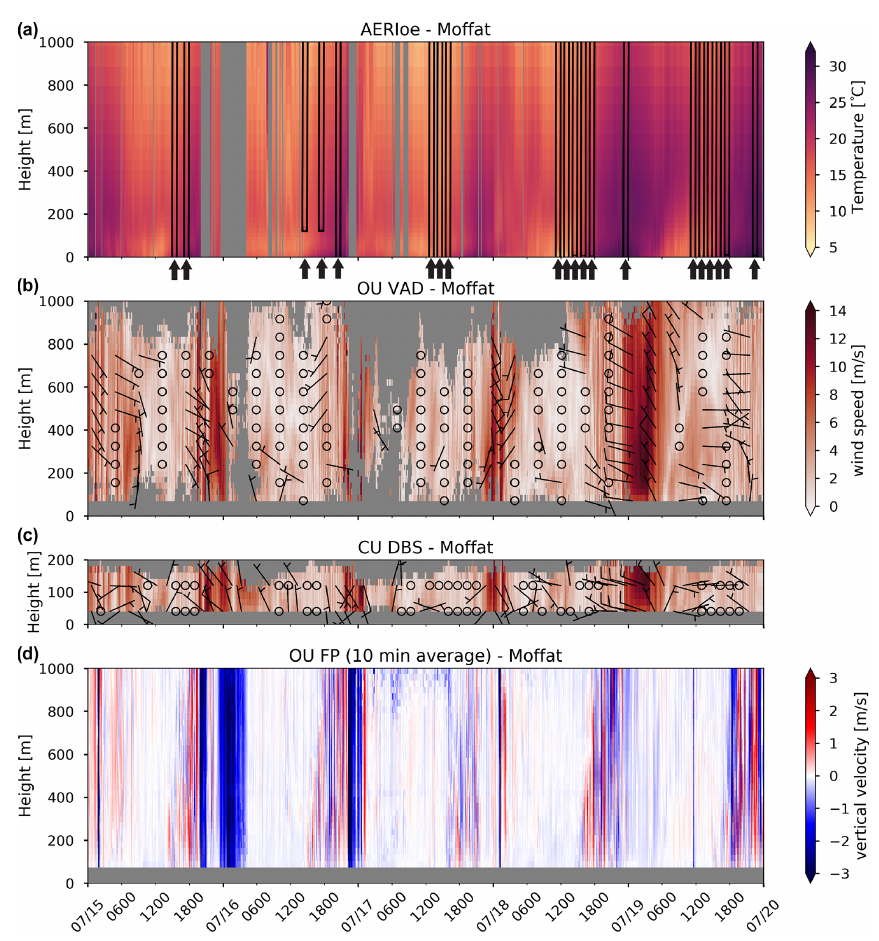
Figure 5. Time–height figures of temperature from the AERIoe retrievals (a) , wind speed and direction from the CLAMPS VAD (b) , wind speed and direction from the CU DBS scan (c) , and 10min averages of the vertical velocity measured from the CLAMPS vertical stare (d) from the full LAPSE-RATE campaign. All of these data were recorded at the Moffat site. Radiosonde data are overlaid and outlined in black on top of the AERIoe retrievals in panel (a) . The launch time of each radiosonde in indicated with a black